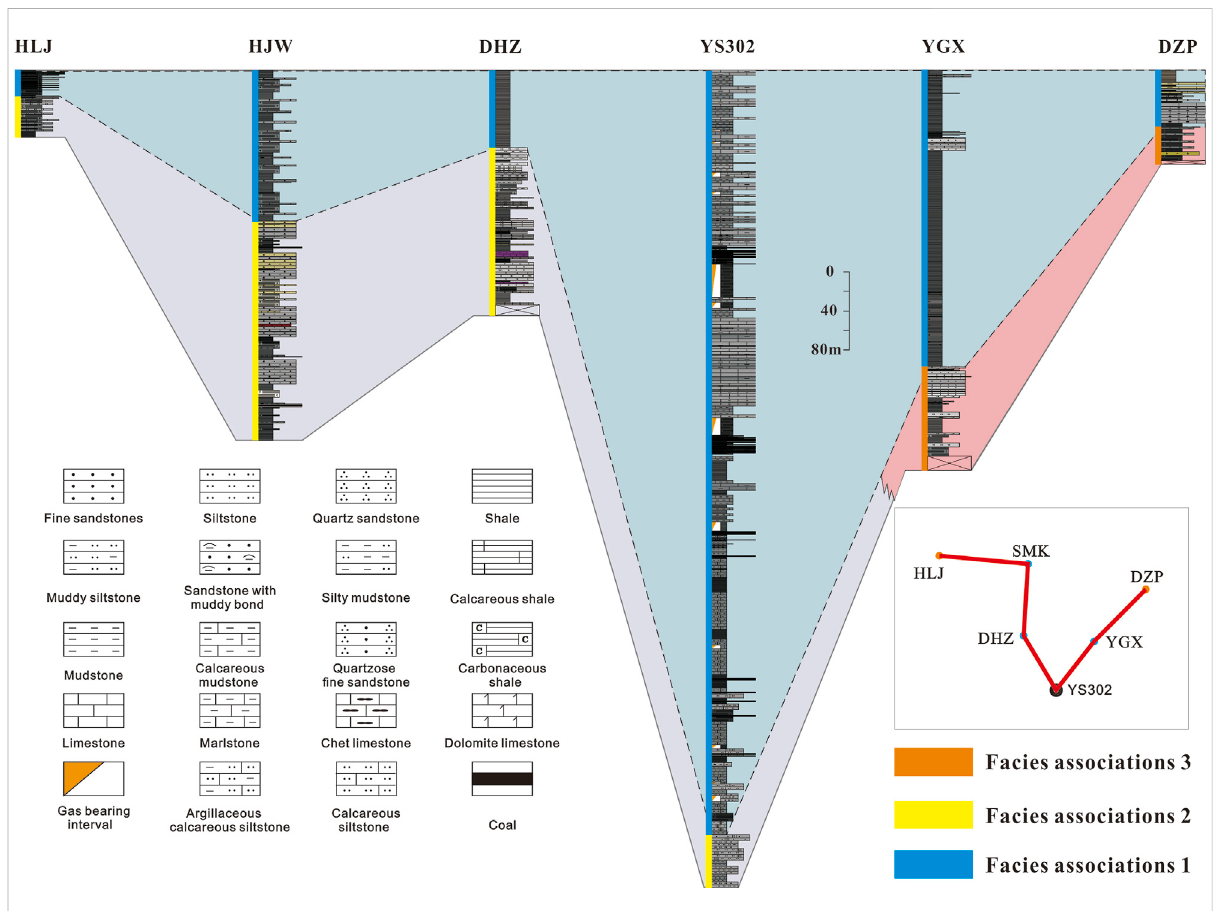
FIGURE 10 The correlation of facies of the Jiusi Formation in a transmeridional